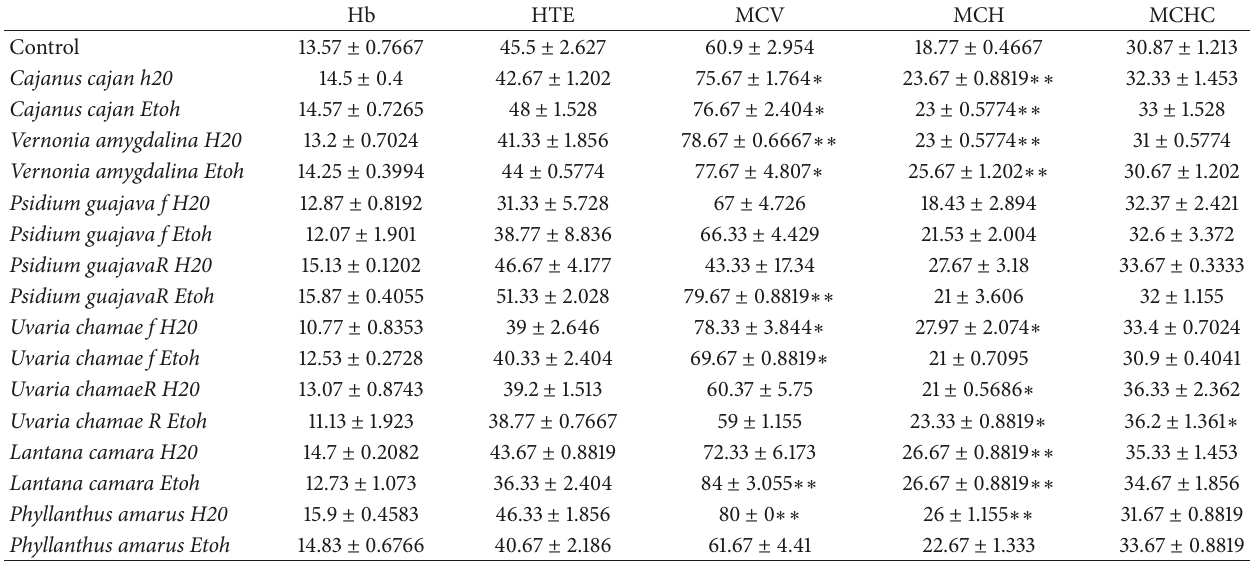
Table 4: Evolution of the hemoglobin (Hb), hematocrit (HTE) of mean corpuscular volume (MCV), the mean corpuscular hemoglobin (MCH), and mean corpuscular hemoglobin concentration (MCHC) of treated rats and